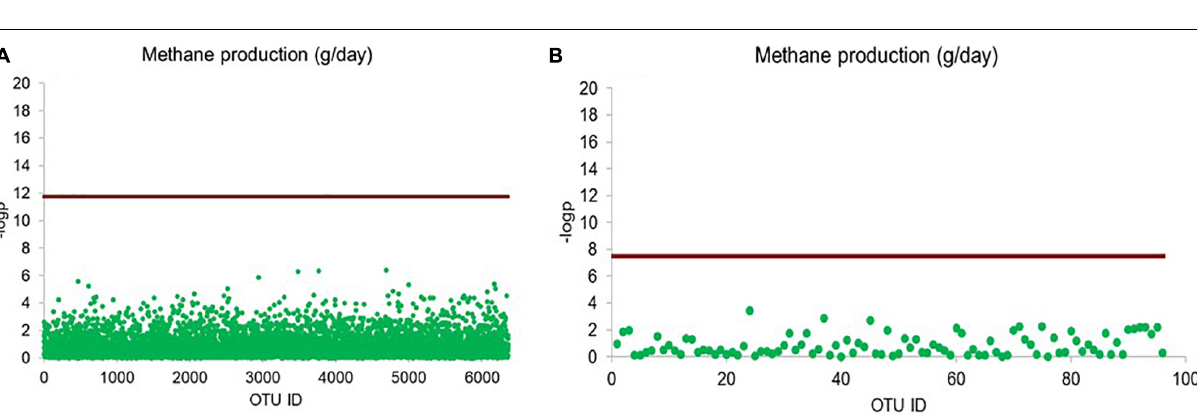
FIGURE 6 | Scatter plot illustrating bacterial and archaeal OTUs significantly affecting methane production (g/day). Rarified sequence number of individual OTUs was used as input for the linear mixed model-based significance detection. Negative log base 10 transformed P value of individual OTUs are shown in y -axis and their corresponding identities are shown in x -axis. Bonferroni correction is used as baseline for significance control, bacterial OTU (0.5/6363) (A) and archaeal OTU (0.5/79) (B) , as indicated by red line and individual OTUs are represented by green dot.